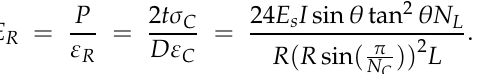
( b ) Figure 17. Elastic modulus of the auxetic stent in the radial direction at two material states: ( a ) rubbery state (high temperature); ( b ) glassy state (low temperature). Assuming the slanted members only stretch when loaded x σ , the bending deformation in the x -direction of unit cell is derived as